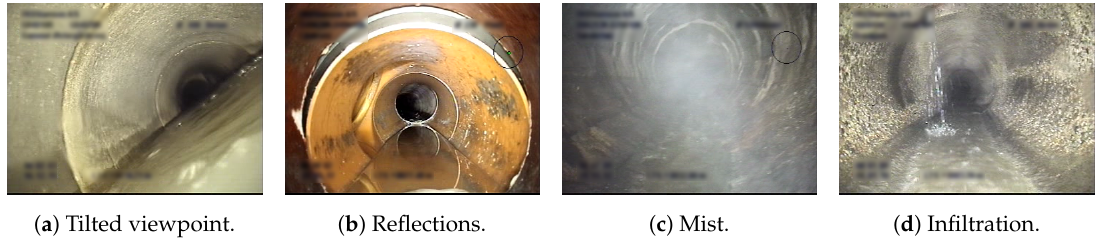
Figure 1. Examples of adverse conditions from Closed-Circuit Television camera (CCTV) footage of sewer pipes which can complicate the water level classification task; ( a ) the camera is tilted such that the entire view is placed above the water line; ( b ) the water surface reflects the surroundings; ( c )